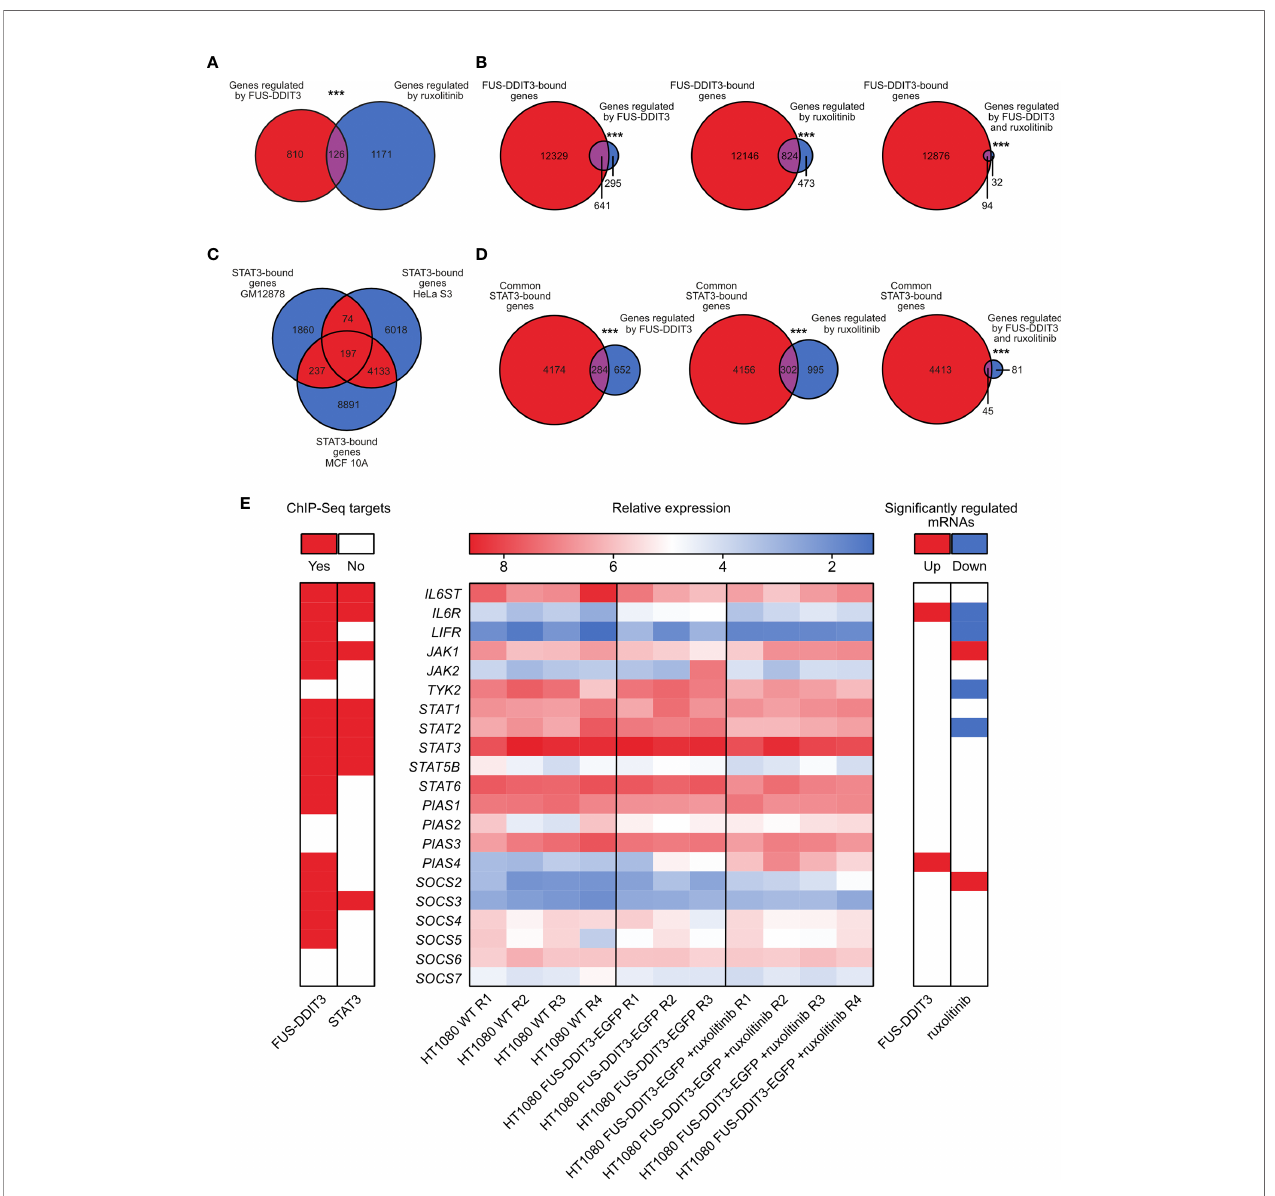
FIGURE 3 | Combined gene expression and chromatin immunoprecipitation sequencing data analysis. (A) Venn diagram showing the overlap between genes signi fi cantly regulated by FUS-DDIT3 expression and ruxolitinib treatment. *** p ≤ 0.001, Fisher ’ s exact test. (B) Venn diagrams showing overlap between FUS-DDIT3- bound genes based on chromatin immunoprecipitation sequencing data and genes regulated by FUS-DDIT3, ruxolitinib, or both FUS-DDIT3 and ruxolitinib. *** p ≤ 0.001, Fisher ’ s exact test. (C) Venn diagram showing overlap between STAT3-bound genes in the human lymphoblastoid cell line GM12878, the cervical adenocarcinoma cell line HeLa S3, and the non-malignant breast epithelial cell line MCF 10A, based on chromatin immunoprecipitation sequencing data. (D) Venn diagrams showing overlap between STAT3-bound genes common for at least two cell lines (red-marked areas in “ C ” ) and genes regulated by FUS-DDIT3, ruxolitinib, or both FUS-DDIT3 and ruxolitinib. *** p ≤ 0.001, Fisher ’ s exact test. Note that the total number of overlapping genes in “ C ” ( n = 4641) and “ D ” ( n = 4458) are not identical, since the overlap in “ C ” was based on pairwise peak comparisons, while the comparisons in “ D ” were based on gene overlaps. (E) Heatmap showing relative mRNA expression of canonical JAK-STAT pathway genes in HT1080 wild-type (WT) and HT1080 FUS-DDIT3-EGFP cells as well as HT1080 FUS-DDIT3- EGFP cells treated with ruxolitinib (middle). R1 – R4 correspond to biological replicates collected at different cell passages. Values are transformed with rlog transformation using the DESeq2 differential expression analysis tool. STAT4 , STAT5A , and SOCS1 were excluded due to low expressions in all samples. Signi fi cantly up- (red) or downregulated (blue) genes due to FUS-DDIT3 expression or ruxolitinib treatment are shown (right) using fold change ≥ 2 and adjusted p - value ≤ 0.05. Con fi rmed FUS-DDIT3 and STAT3 targets from public chromatin immunoprecipitation data are marked in red (left). ChIP-Seq, chromatin immunoprecipitation